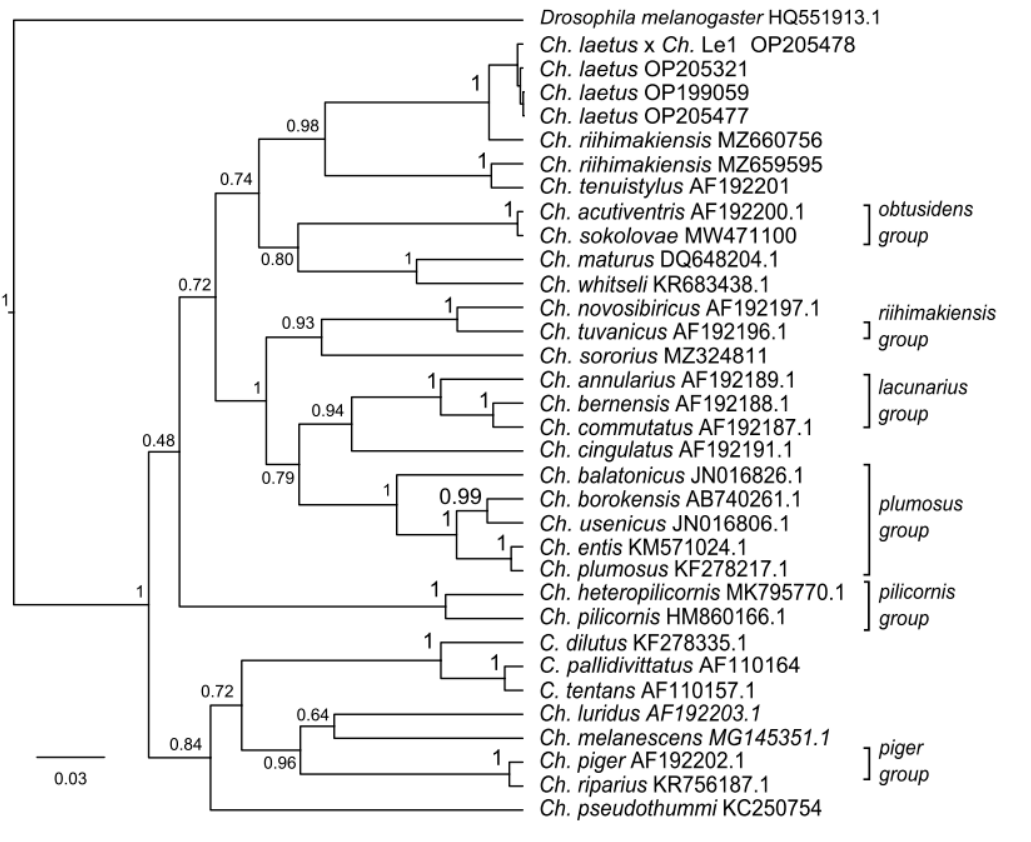
Figure 6. Bayesian tree of the analyzed samples of Chironomus spp. inferred from COI sequences. The species name, GenBank accession number, and group name are shown to the right of the branches. Support values are given if they exceed 0.3. The numbers at the nodes indicate posterior probabilities.